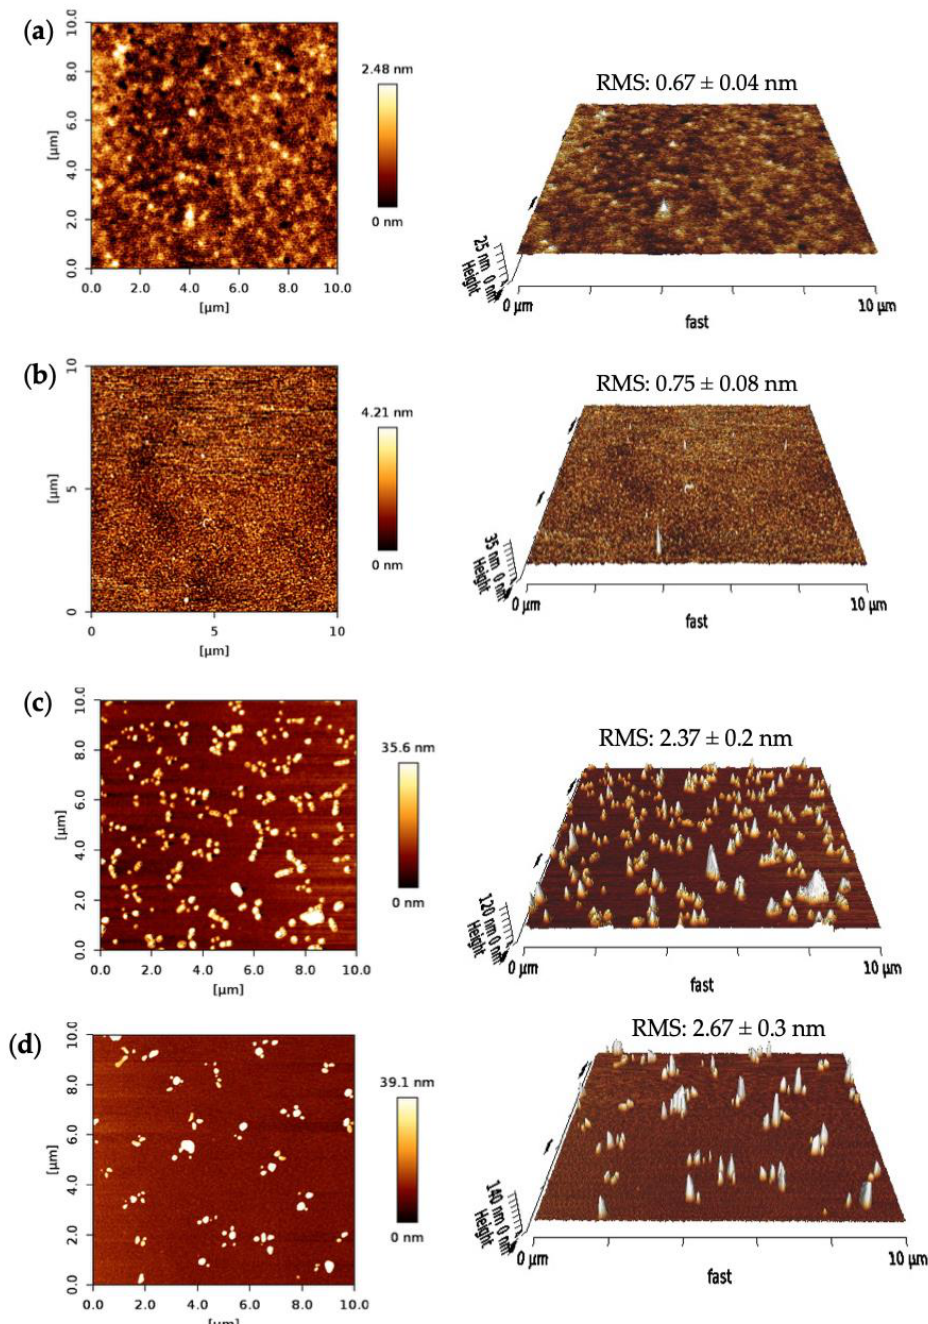
Figure 8. AFM 2D height images and 3D surface topographies of ( a ) bare, ( b ) MUDA coated, ( c ) nanoMIP immobilized and ( d ) protein-bound surfaces. All the RMS values are the result of 10 cross-sectional data.